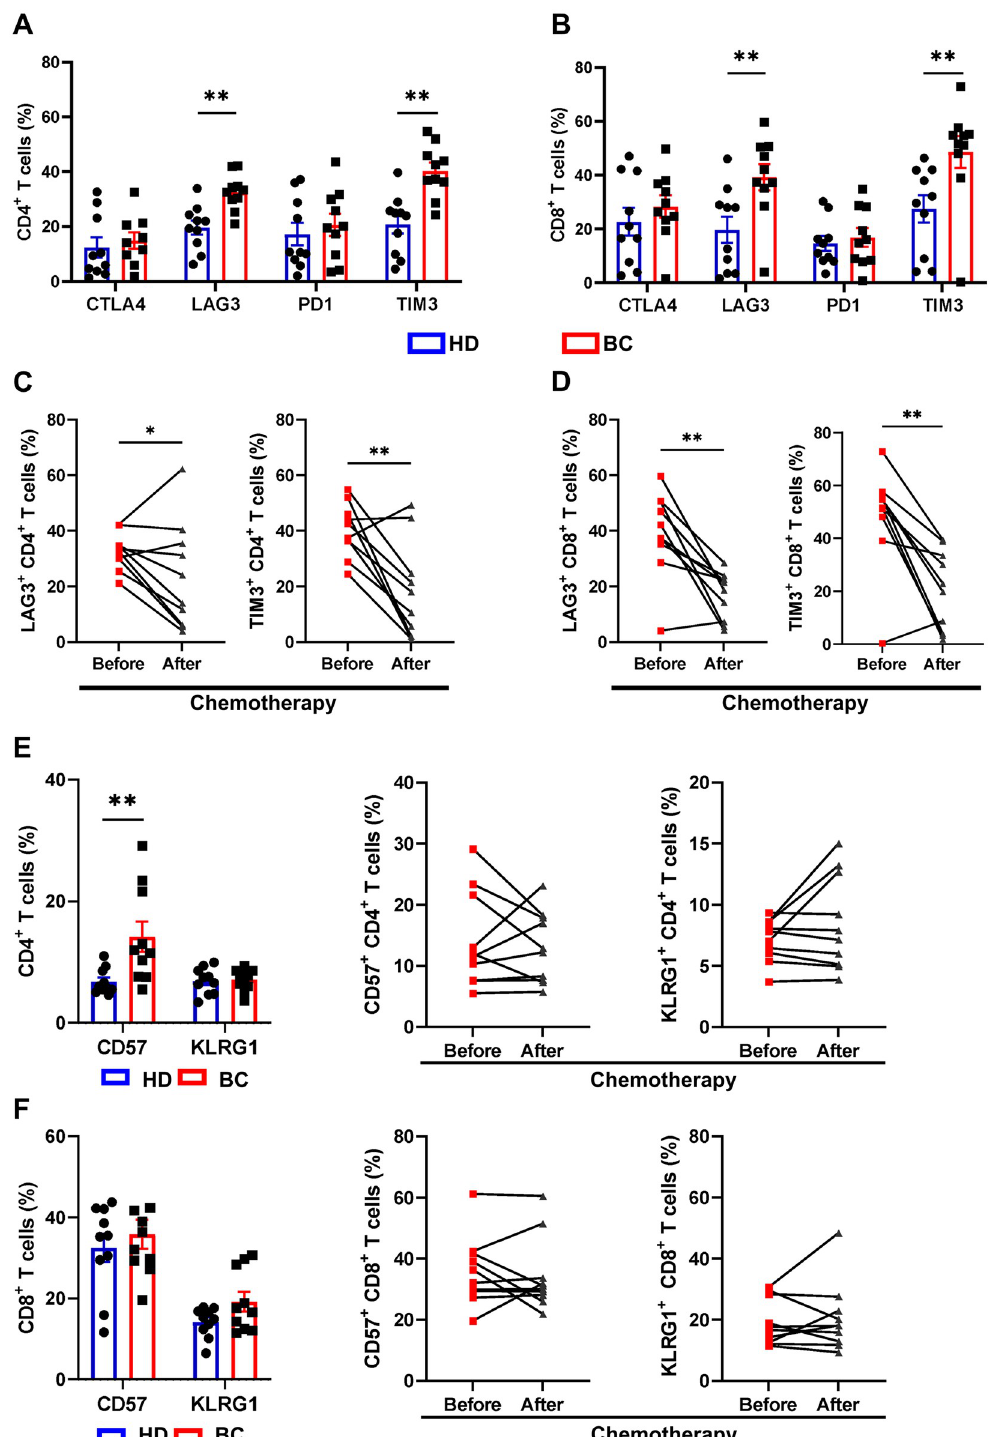
Fig 3. Change in senescence and exhaustion markers of T cells of BC patients. A-B- Exhaustion markers expression on CD4+ and CD8+ T cells, as assessed by flow cytometry on PBMCs from ten healthy donors (blue bars) and ten BC patients (red bars). C-D . Frequencies of LAG3+ and TIM3+ cells within total CD4+ and CD8+ T cells compartments in BC patients before and after chemotherapy. E-F . Senescence markers expression on CD4+ and CD8+ T cells, as assessed by flow cytometry on PBMCs from ten healthy donors (blue bars) and ten BC patients (red bars). Frequencies of CD57+ and KLRG1+ cells within total CD4+ and CD8+ T cells compartments in BC patients before and after chemotherapy. Data presented as means ± SEM ( �� p < 0.01; � p <